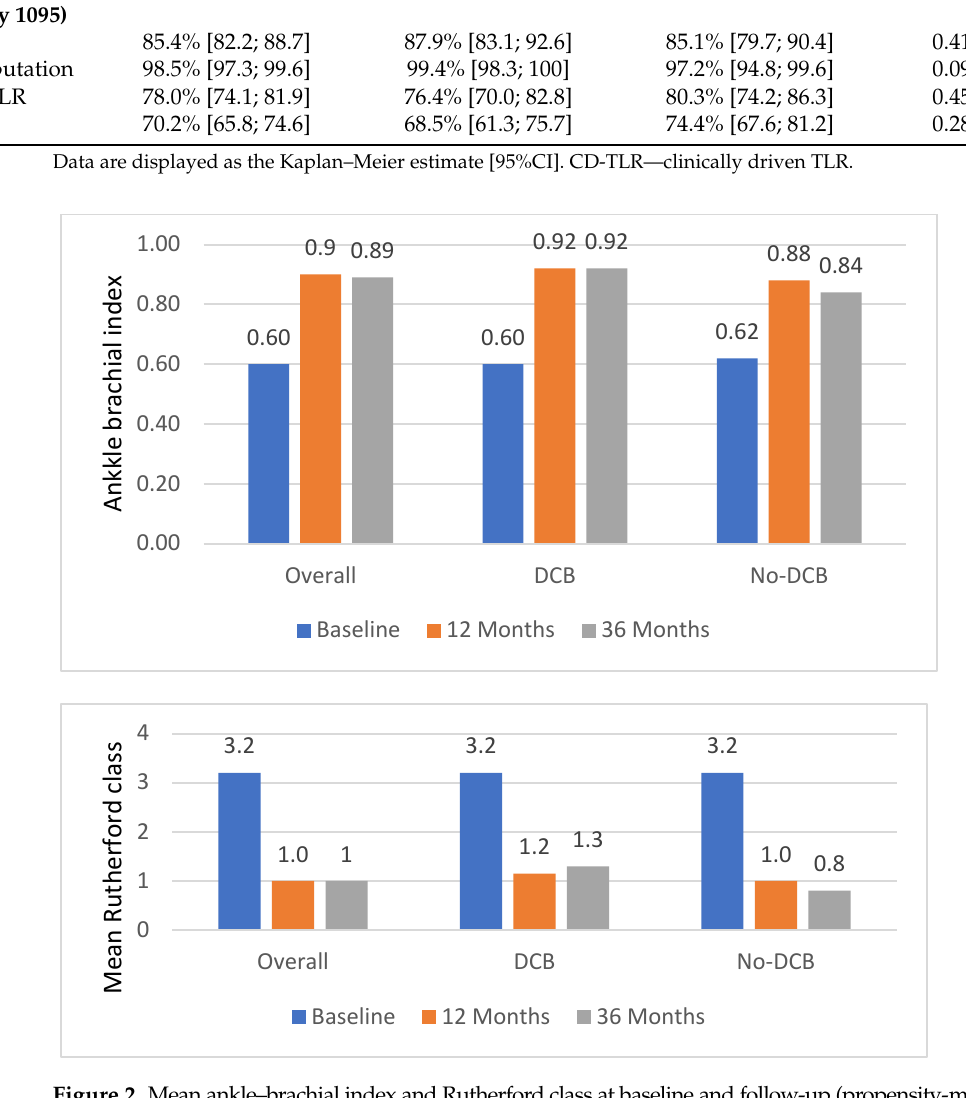
Figure 2. Mean ankle–brachial index and Rutherford class at baseline and follow-up (propensity-matched cohort). Upper panel: there was no statistically significant difference in terms of ankle–brachial index amongst the groups. At baseline, 12 and 36 months, ankle–brachial index data were available for 173, 150 and 115 patients in the DCB group, and for 143, 130 and 66 patients in the no-DCB group. Lower panel: in terms of the Rutherford class, there was a significant difference between the groups at 12 and 36 months ( p = 0.048 and p = 0.0001, respectively). The mean Rutherford class was available for 194, 149 and 141 patients in the DCB group and 193, 141 and 118 in the no-DCB group .